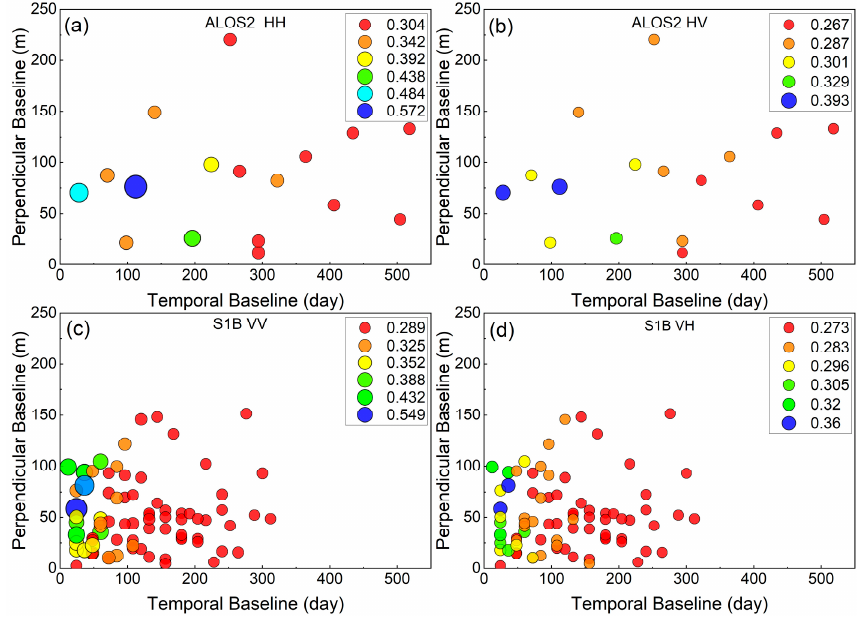
Figure 5. Interferometric coherence as a function of the temporal and perpendicular baselines: ( a ) ALOS2 HH polarization mode; ( b ) ALOS2 HV polarization mode; ( c ) S1B VV polarization mode; ( d ) S1B VH polarization mode.